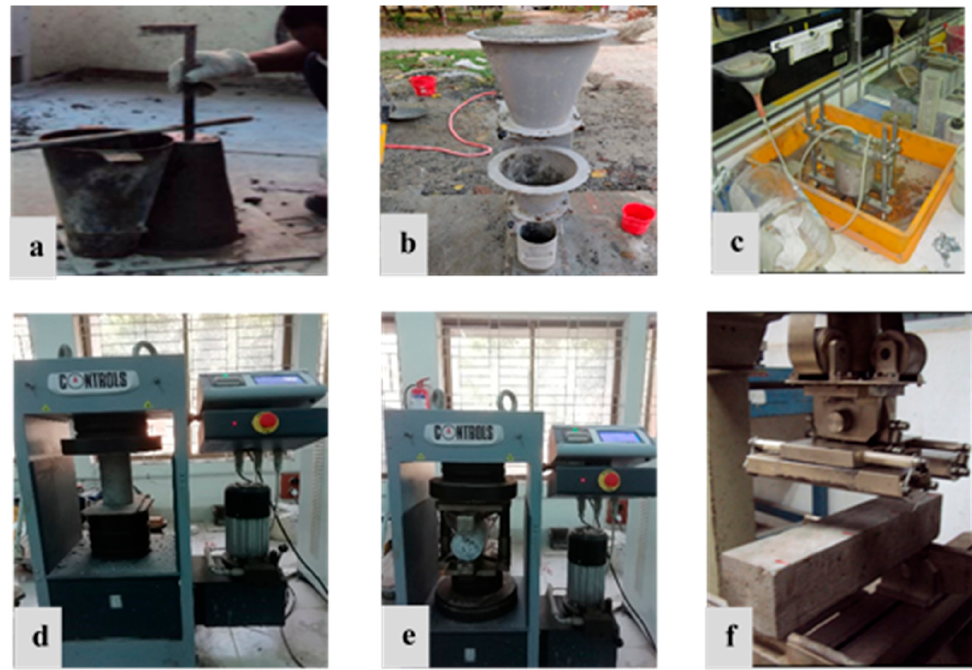
Figure 5. Testing setups: ( a ) slump test, ( b ) compaction test, ( c ) initial surface absorption test, ( d ) compressive strength test, ( e ) splitting tensile strength test, and ( f ) flexural strength test.